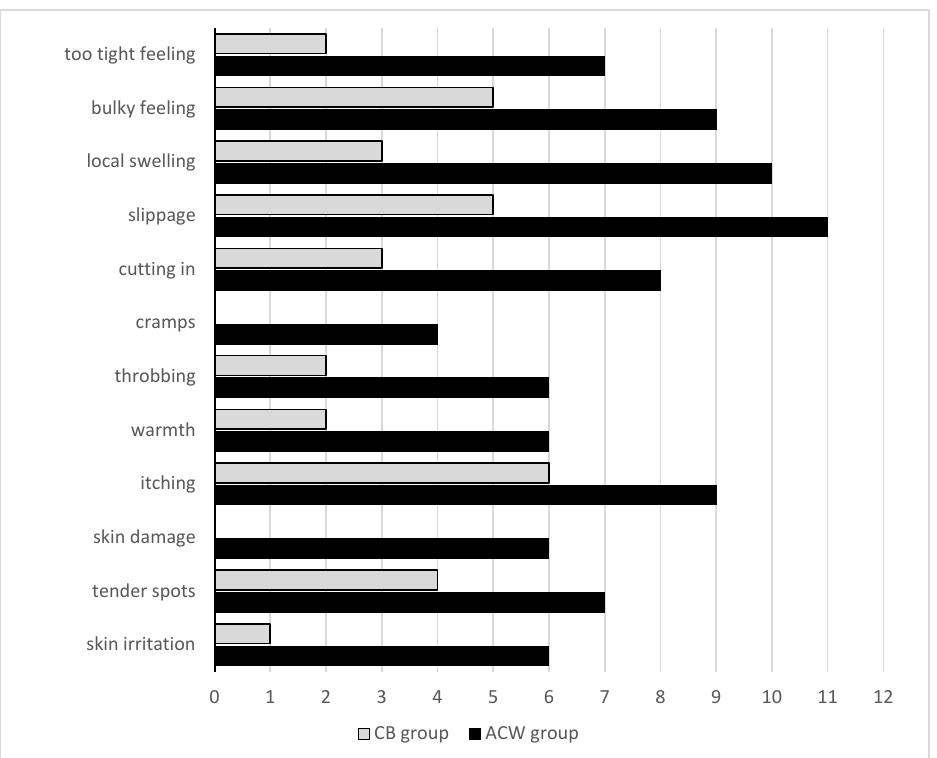
Figure 3. Number of patients with complications of compression within the groups.